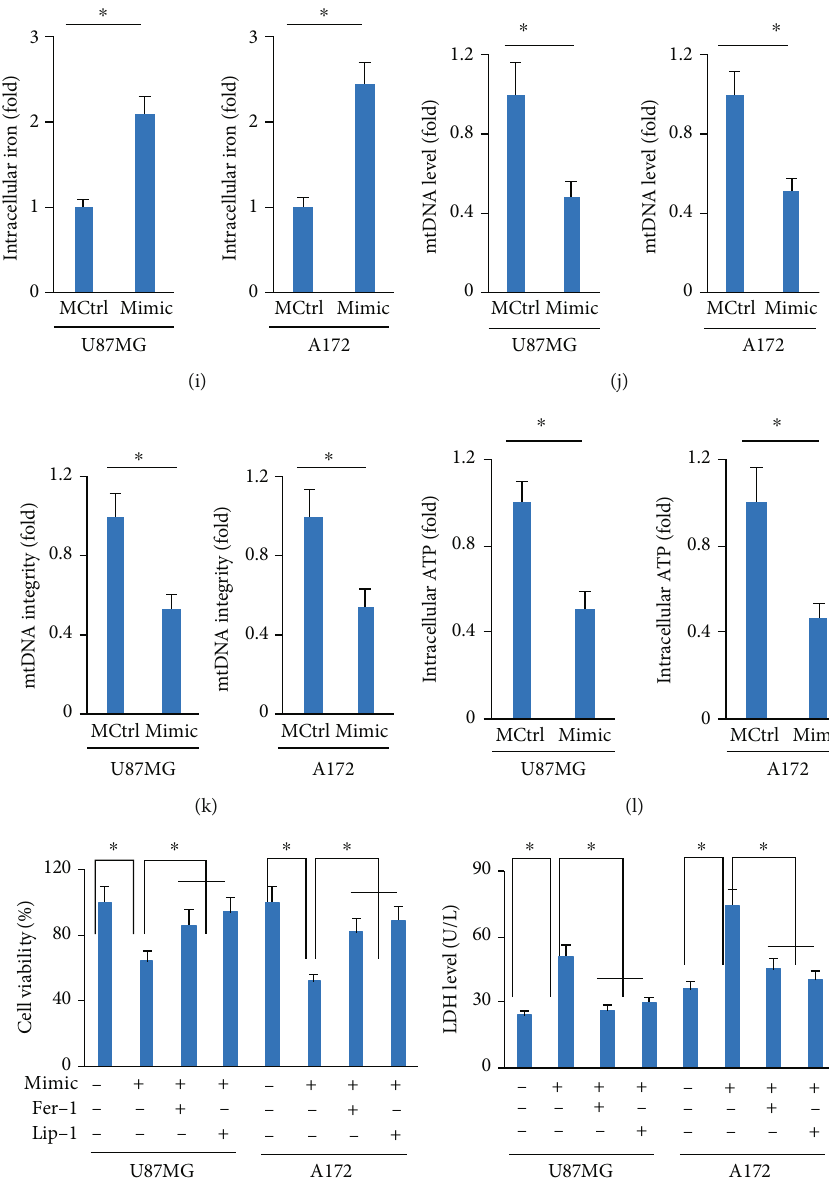
Figure 2: The miR-147a mimic triggers ferroptosis of human glioblastoma cells. (a – b) miR-147a level in human glioblastoma cells treated with erastin or RSL3. (c) ROS level detected by DCFH-DA probe. (d) MDA level in cells treated with or without the miR-147a mimic. (e – f) 5-HETE, 12-HETE, and 15-HETE levels in the medium from cells treated with or without the miR-147a mimic. (g – h) GSH level and GPX4 activity in U87MG and A172 cells. (i) Relative level of intracellular iron. (j – k) Quanti fi cation of mtDNA content and integrity. (l) Quanti fi cation of intracellular ATP level. (m) Cell viability and LDH releases in the miR-147a mimic-treated human glioblastoma cells with Fer-1 or Lip-1 protection. N = 6 for each group. Data were expressed as the mean ± SD , and P < 0 : 05 was considered statistically signi fi